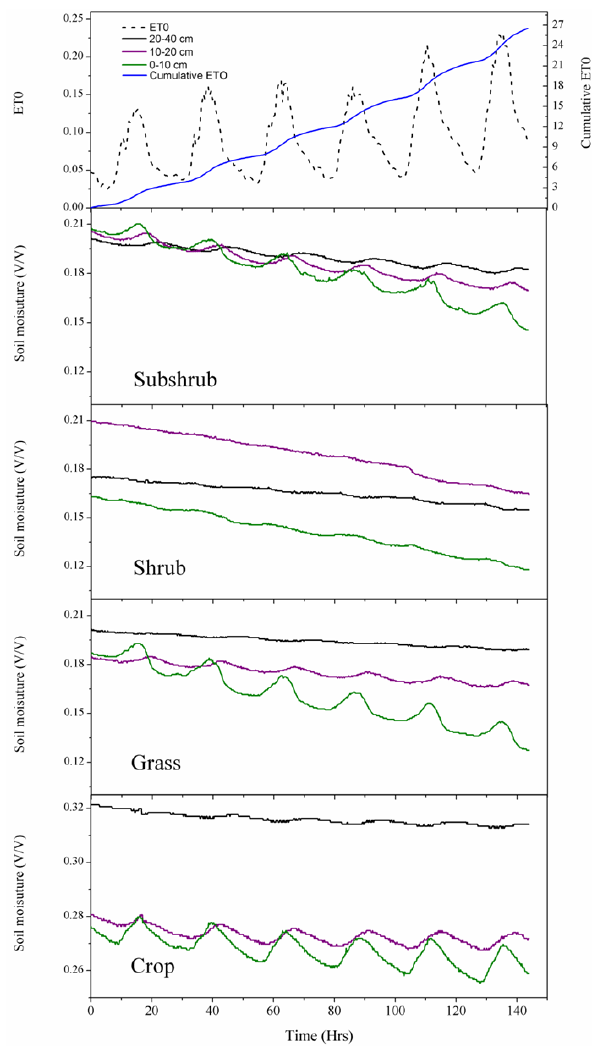
Fig. 8. Soil moisture decrease process under the five land cover types from 25 August to 31